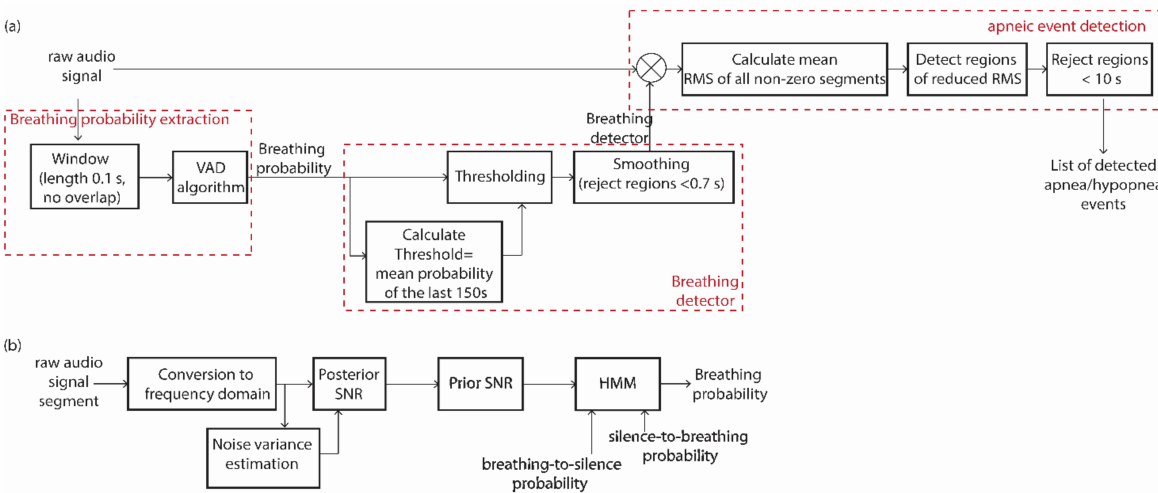
Figure 2. ( a ) Block diagram of the audio signal processing for the extraction of the list of detected apnea events from raw audio recordings. It comprises: (i) the breathing probability extraction algorithm, (ii) the conversion of the breathing probability to a breathing detector, and (iii) the detection of apneic events based on the raw audio signal and the breathing detector. ( b ) Block diagram of the VAD algorithm that is analytically described in